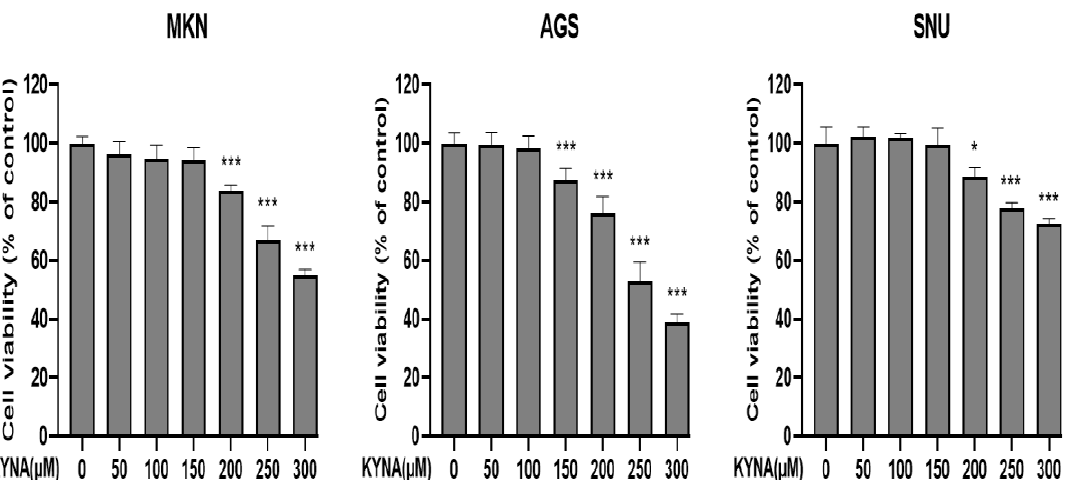
Figure 2. Effect of KYNA on cell viability of gastric cancer cells. The inhibition of cell viability was measured by a 3-(4,5-dimethylthiazol-2-yl)-2,5 diphenyltetrazolium bromide (MTT) assay with various concentrations (0, 50, 100, 150, 200, 250 and 300 µ M) of KYNA for 24 h. Cell viability is represented in percentage relative absorbance compared to the controls. The results obtained from three independent experiments were expressed as mean ± standard error of the mean (SEM) compared with the control group. * p < 0.05, *** p < 0.001.